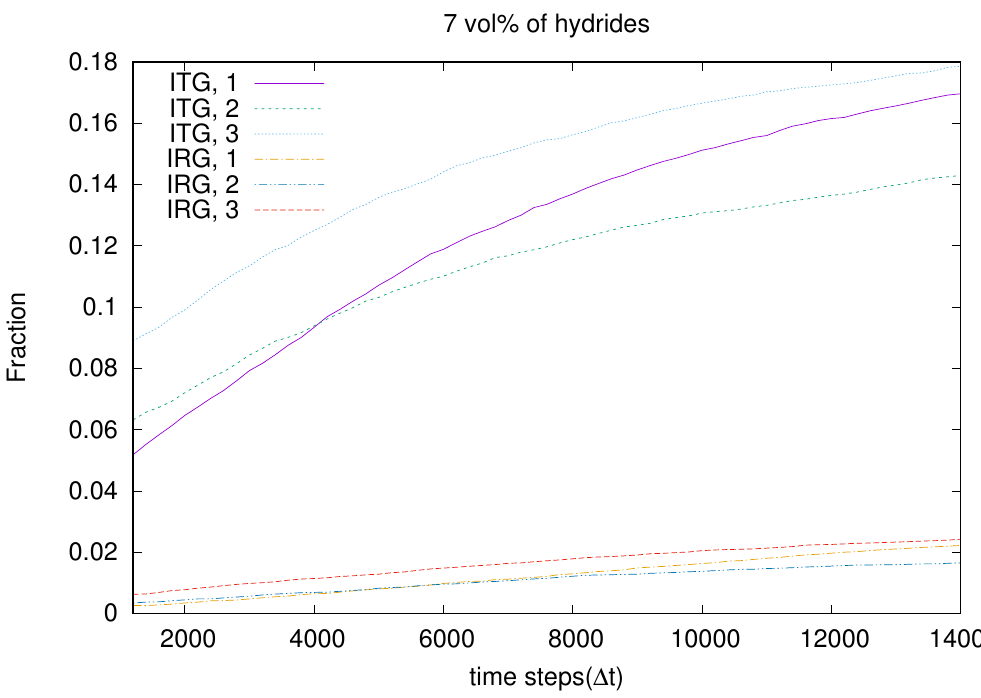
Figure 6. Plot of fractions of intra-granular and inter-granular hydrides with respect to time in the presence of 7 vol% hydrides. The fractions of hydrides with 1, 2 and 3 structural variants cases are plotted. ITG and IRG stand for Inter-granular, Intra-granular, respectively and the numbers next to comma indicate the number of structural